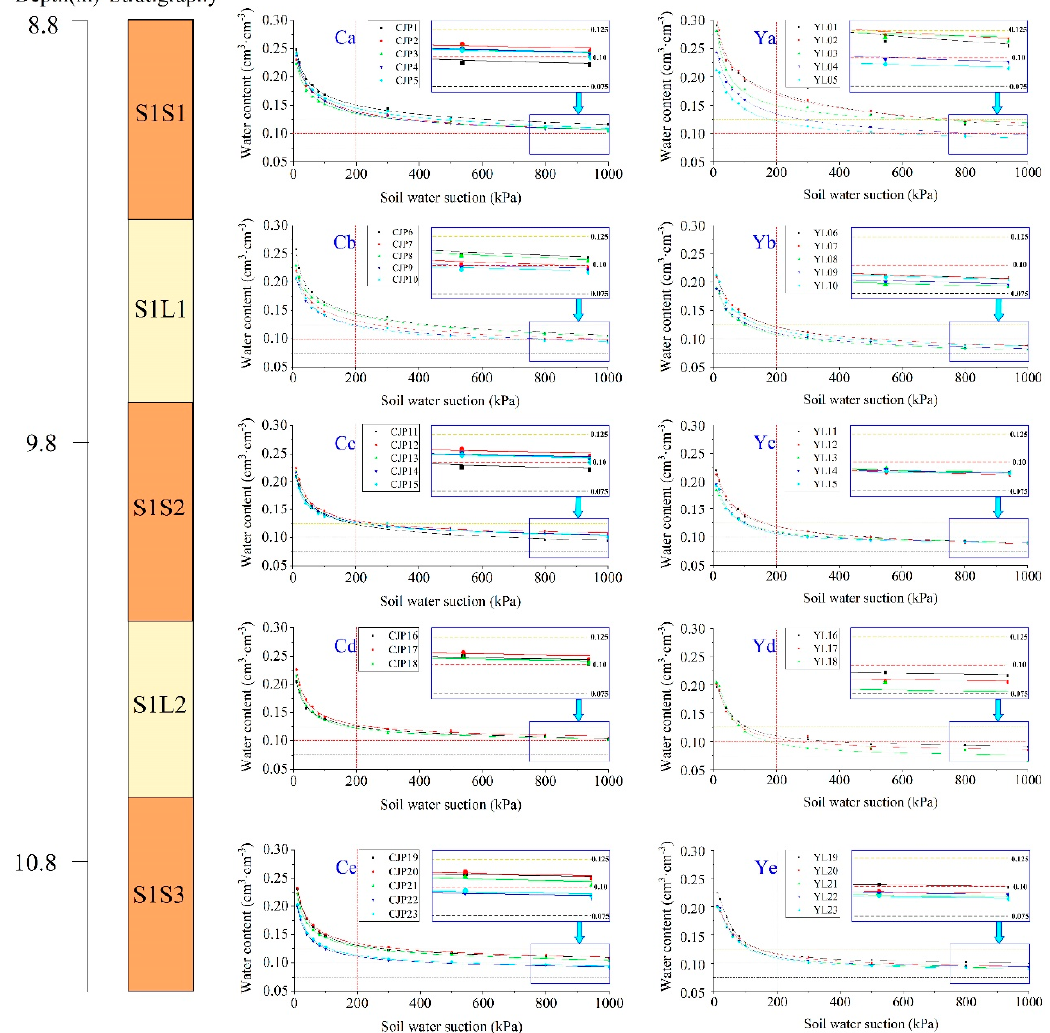
Figure 5. Soil water characteristic curves (SWCCs) of S1 in Caijiapo (CJP) profile (Ca–Ce) and Yangling (YL) profile (Ya–Ye). The soil water content at high suctions are magnified in blue rectangles. Taking the red dotted straight line (water content of 0.10 cm 3· cm –3 ) as the reference line, the water contents under 800–1000 kPa at S1S1 and S1S3 were higher than other sub-layers of the YL profile.